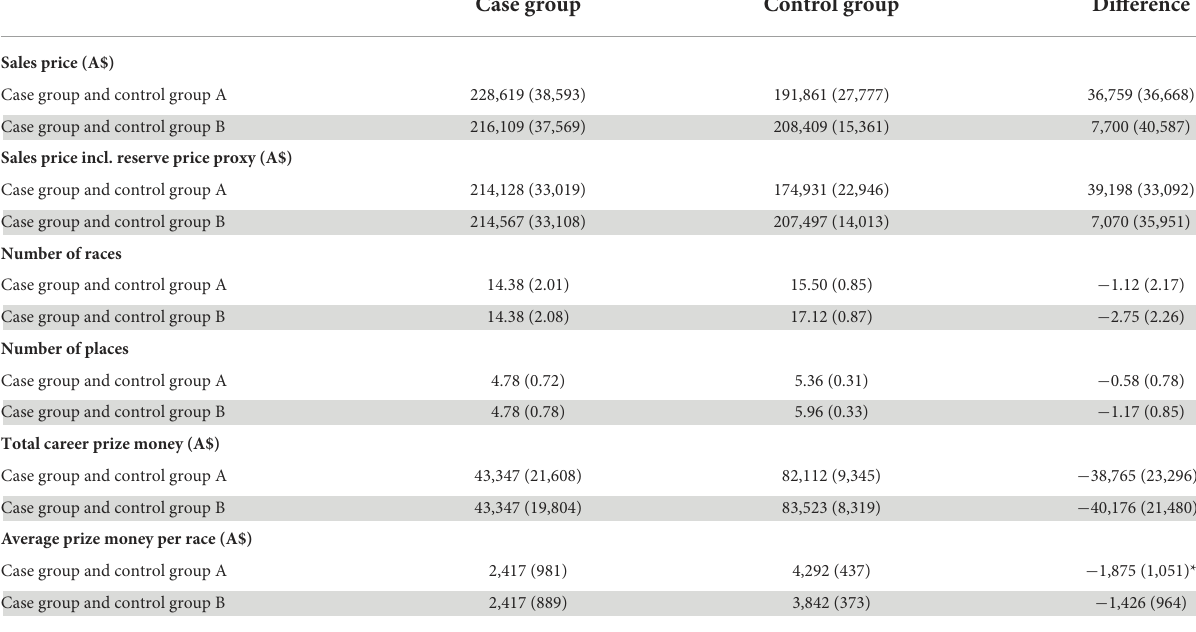
TABLE 4 Means (standard error of the mean) of the case group and control groups for sales and racing performance and their mean differences (standard error of the mean) . Case group Control group